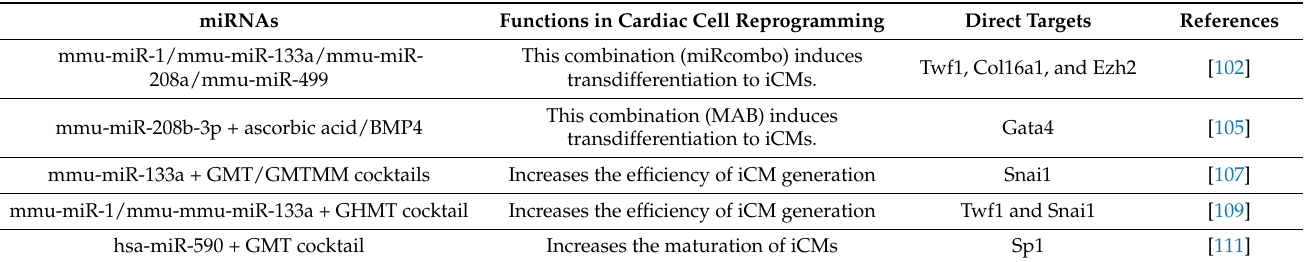
Table 3. Summary of the main miRNAs discussed in the text with their functions in direct cardiac